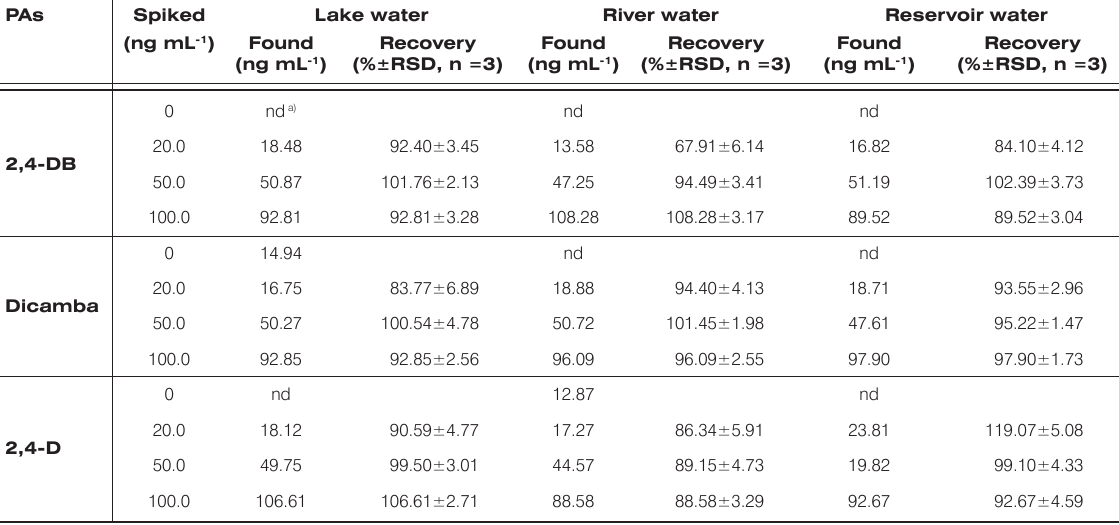
Table 3. Determination results of PAs and method recoveries in real water samples.